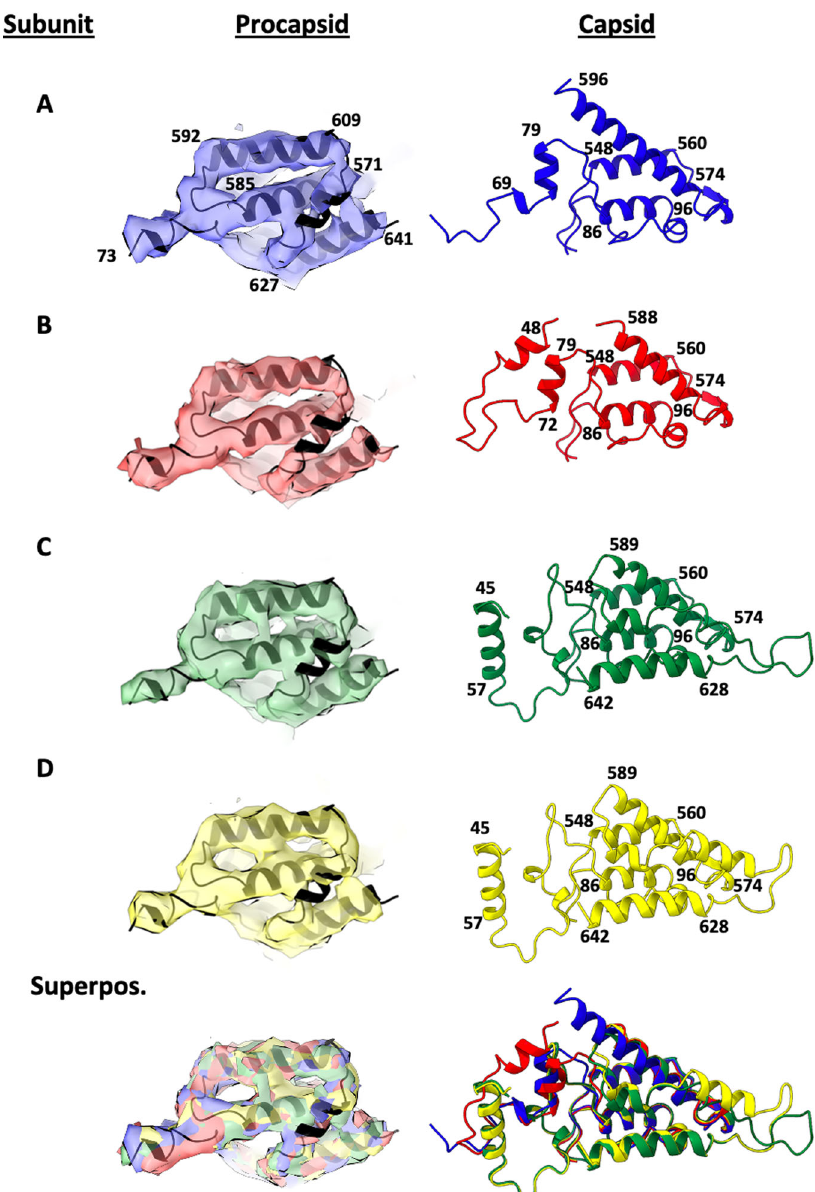
Fig. 6 Internal helical domains of procapsid and capsid subunits in one icosahedral asymmetric unit. Left: Procapsid cryo-EM density (6.6 Å resolution) and model for the internal helical domain (N-terminal and gamma peptide) of subunits A, B, C, D all viewed in the same orientation. The model of the internal helical domain (in black), re fi ned as an identical rigid body for all four subunits, precisely fi ts the unique cryo-EM densities for the four subunits. Superposition of the four densities and models (bottom left) demonstrates the closely similar structures in this region of the procapsid. Right: Re fi ned capsid models (2.7 Å resolution) of the internal helical domain in each of the four subunits and their superposition (bottom) reveals large differences from each other and the procapsid demonstrating substantial refolding of these sequences during